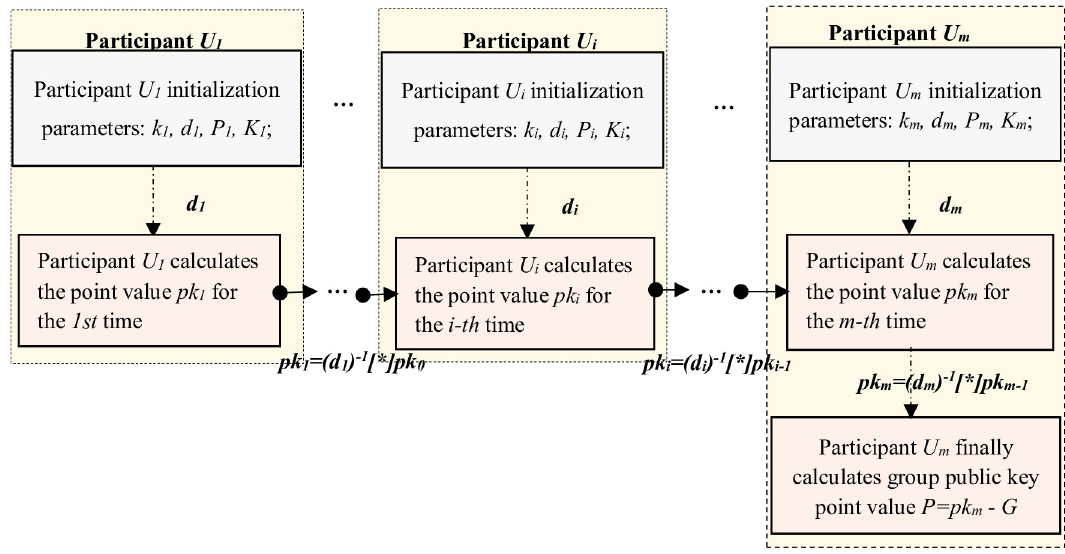
Fig 2. Key generation flow